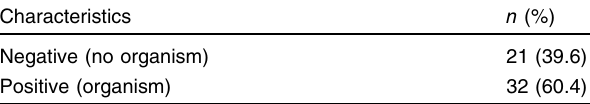
Table 2 Gram stain results in the studied group